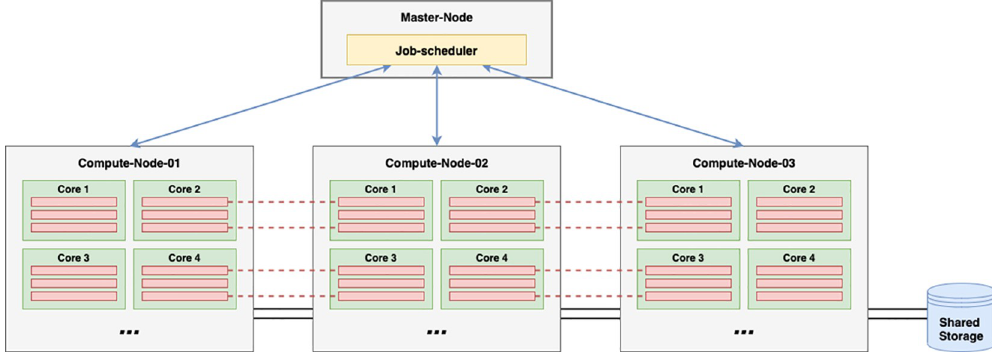
Fig 2. Parallelism in a typical HPC cluster. The job scheduler runs on the master node and controls the highest level of parallelism in running jobs on each node (blue arrows). For example, in a variant calling pipeline, each node may perform the calling for an individual chromosome and could use multiple threads per core—3 threads per core are depicted, for a total of 12 per chromosomal job. In MPI jobs, threads on one node can communicate with threads on other nodes through inter- process communication (depicted in red dashed lines). HPC, high-performance computing; MPI, Message Passing